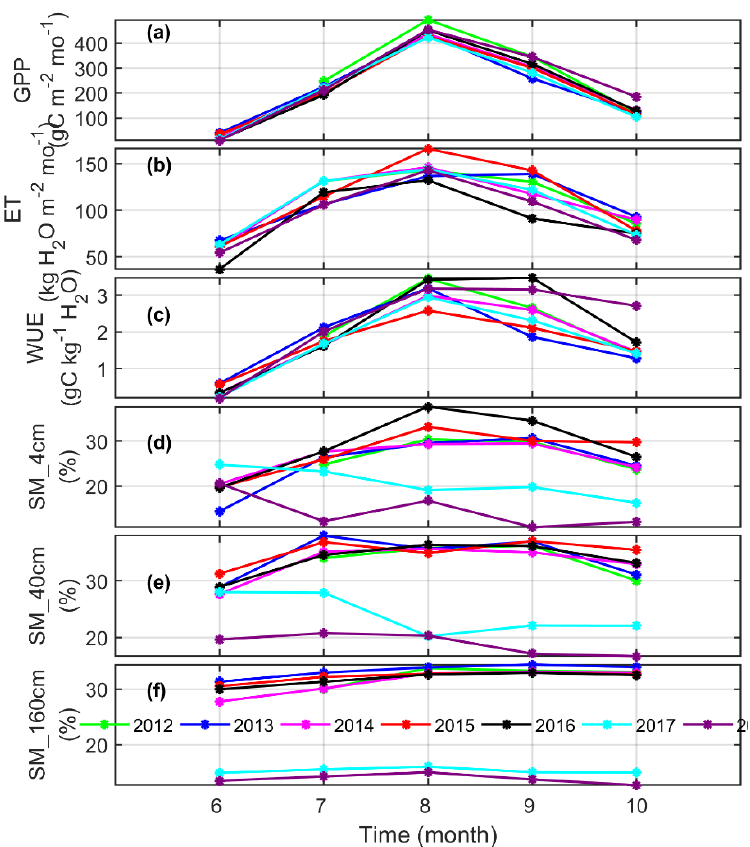
Figure 6. Monthly variations of gross primary production (GPP)( a ), evapotranspiration (ET)( b ), ecosystem water use efficiency (WUEe)( c ), and soil moisture (SM) at different layers during the growing seasons (i.e., periods from May to September)( d – f ).